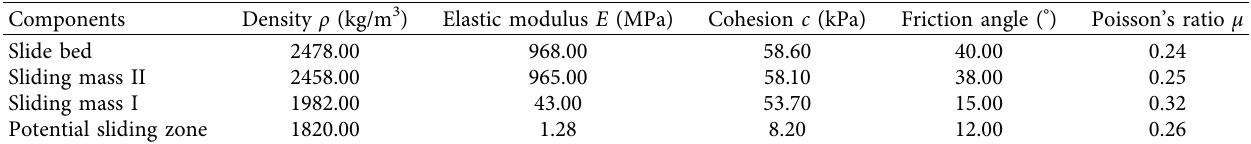
Figure 2: The typical section of the prototype slope. Table 1: Material parameters for the prototype